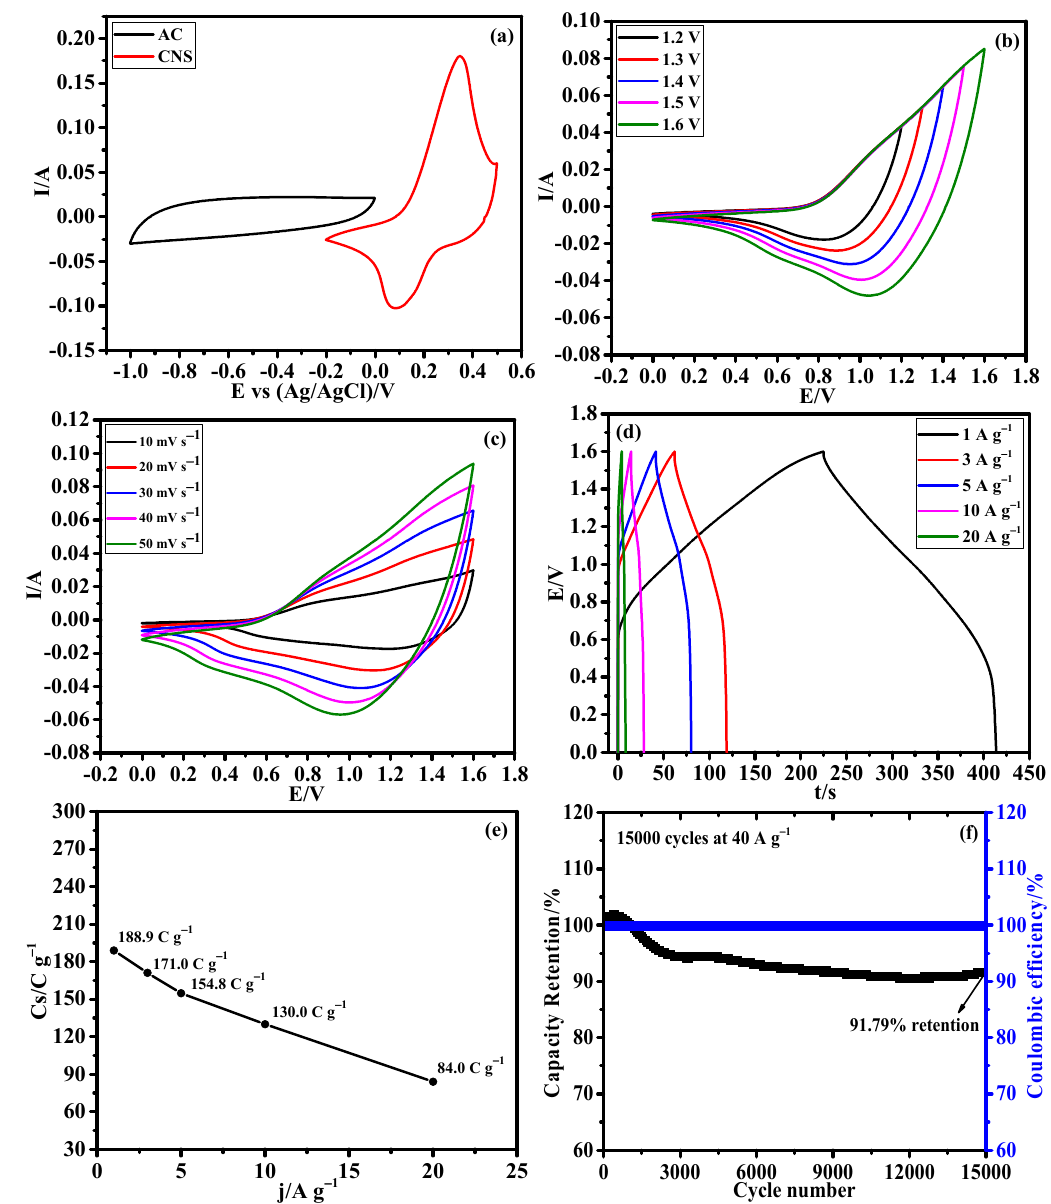
Figure 9. Hybrid supercapacitor performance of CNS//AC device. ( a ) CV curves of AC and CNS electrodes at 50 mV s − 1 , ( b ) CV curves at different potential windows from 0 − 1.2 to 0 − 1.6 V, ( c ) CV curves at different scan rates from 10 to 50 mV s − 1 , ( d ) GCD curves at different current densities, ( e ) plot of specific capacities Vs. different current densities, and ( f ) long-term stability performance of the HSC device for 15,000 cycles at 40 A g − 1 .